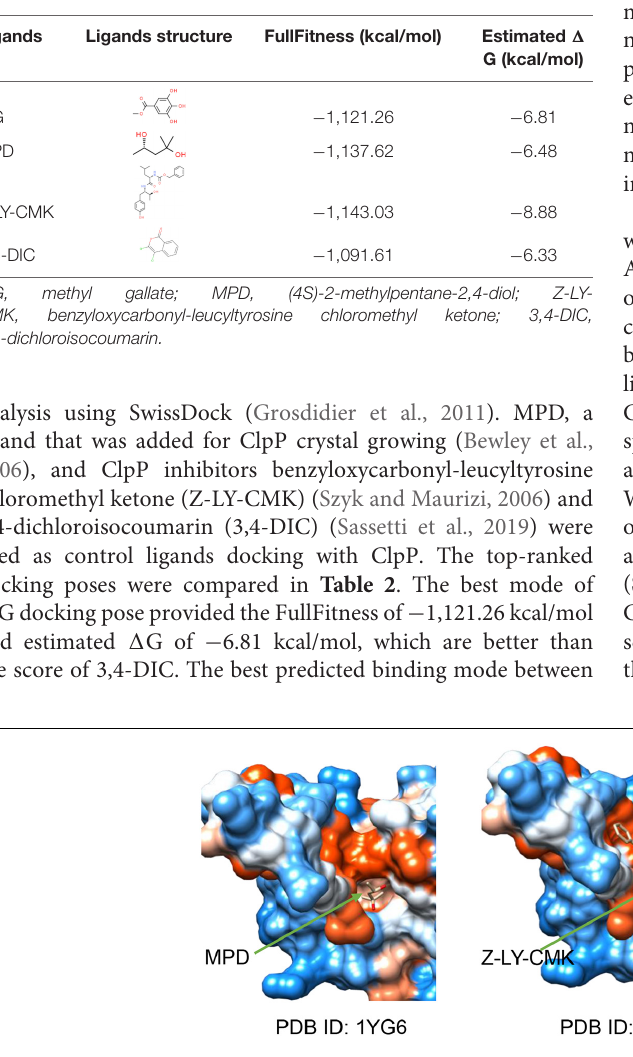
Frontiers in Microbiology |